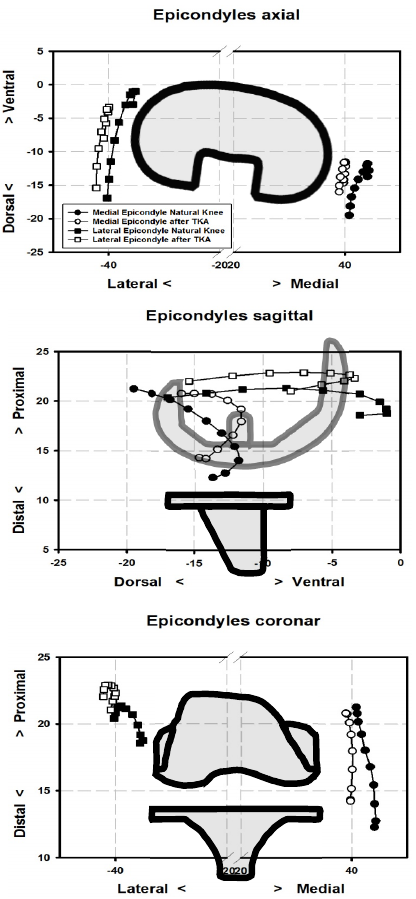
Figure 1. According to Burmester, fibres and insertion points of the collateral ligaments correspond to two-third-order curves, which are related to the articular surface and intersect at the crossing point of the four-bar linkage. This guarantees tensioned ligamentous fibres throughout flexion.